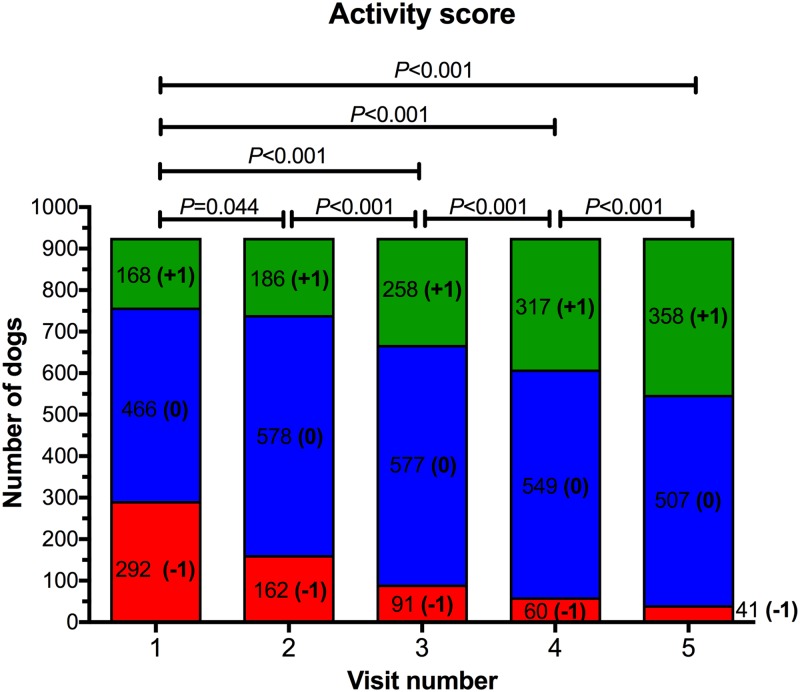
Activity scores for dogs during the study.Activity score was subjectively determined at each visit after a discussion between the veterinarian and owner (Table 3). At each visit, blocks with different colours represent the proportion of dogs assigned an activity score of -1 (red), 0 (blue) and 1 (green), respectively. The number of dogs assigned to each category is also shown.